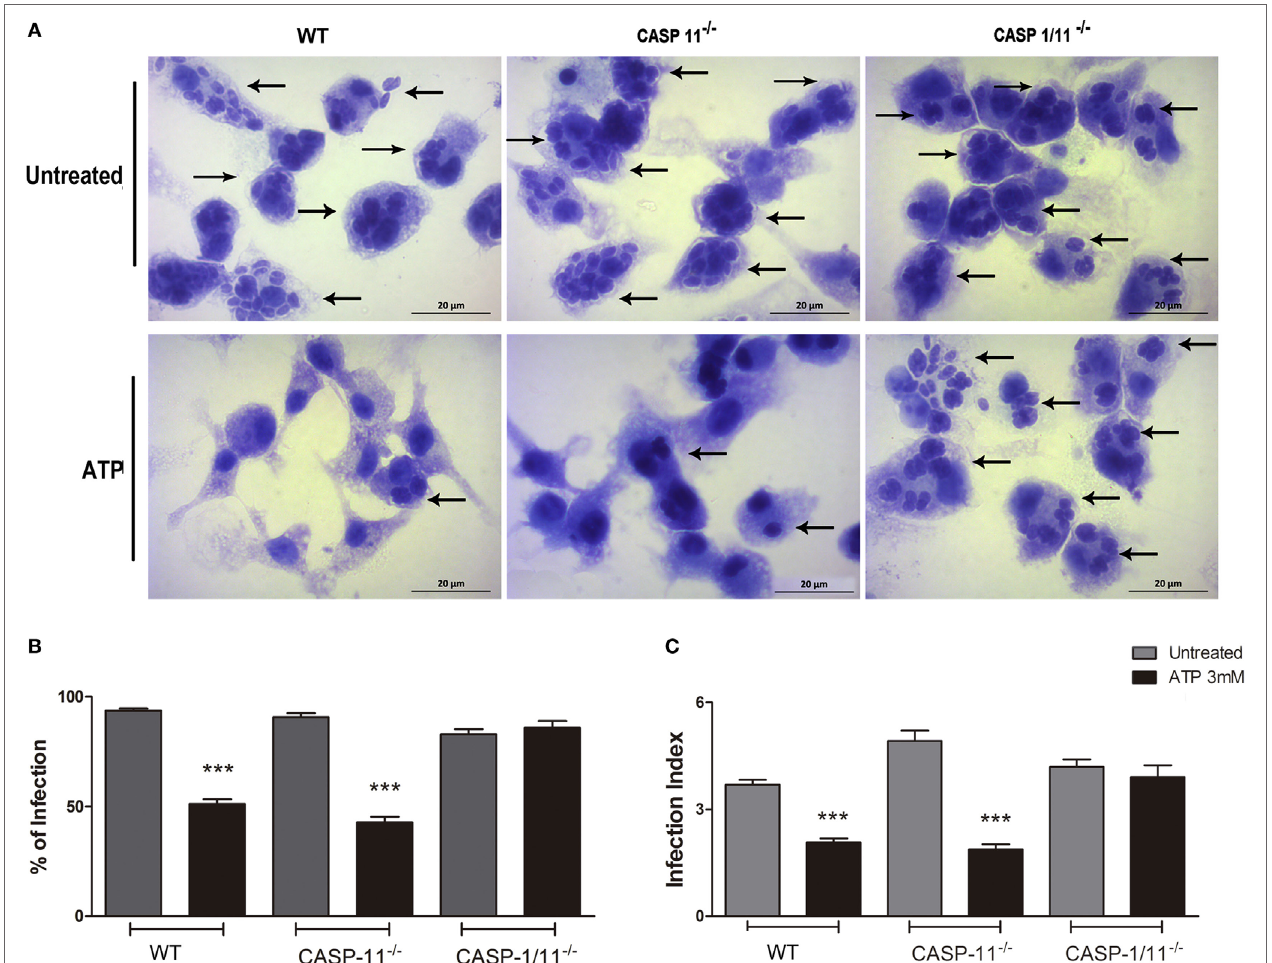
FigUre 3 | P2X7 receptor activation triggers T. gondii elimination via a canonical (but not via a non-canonical) inflammasome. Bone marrow-derived macrophages (BMDMs) from C57BL/6 (wild-type), and from Caspase-11 − / − and Caspase1/11 − / − knockout mice (lacking non-canonical and canonical inflammasome effectors, respectively) were infected with T. gondii tachyzoites for 2 h and then kept untreated, or were treated 3 mM extracellular ATP for 30 min. Then, cells were incubated at 37°C for a total of 18 h, and stained with Panoptic, for light microscopy observation [ (a) ; representative images of three independent experiments] and for the quantification of the % of infection (B) and the infection index (c) . We observed reduced parasite load in wild-type and Caspase-11 − / − BMDMs, but not in Caspase-1/11 − / − cells. Black arrows indicate parasitophorous vacuoles containing T. gondii tachyzoites. Micrographs are representative of three independent experiments. Data represent mean ± SEM of three independent experiments performed in triplicates. *** p ≤ 0.001 vs. untreated (by two-tailed t